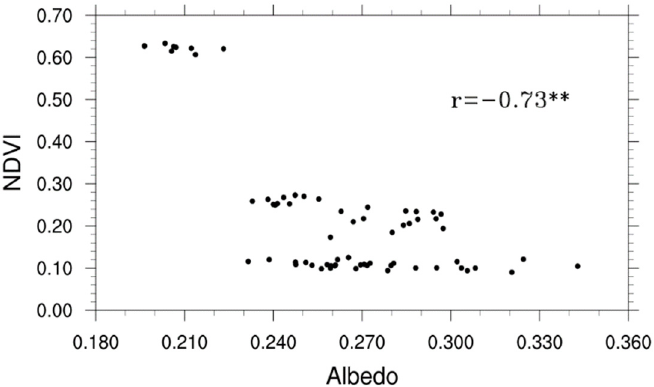
Figure 13. Relationship between the monthly average of NDVI and the monthly average of surface albedo. ** Significantly correlated at the 0.01 level (bilaterally).